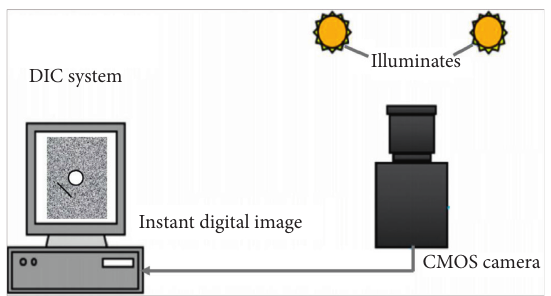
Figure 3: Schematic diagram of the DIC system in the tests modified from reference [45].